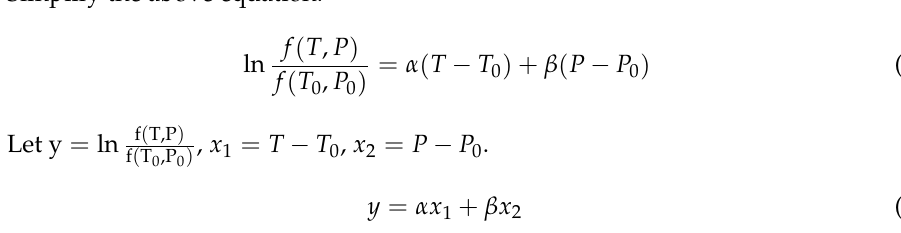
Figure 7. Comparison of predicted and measured plastic viscosity of drilling fluids. Based on the above experimental parameters, Clark and Fontenot conducted well- bore swab/surge pressure testing experiments under different conditions. One set of the drill string tripping speed and surge pressure measurement results at a well depth of 4591 m is shown in Figures 8 and 9. The input speed was 0.7584 m/s , and the maximum value of the surge pressure was 9.3579 MPa .